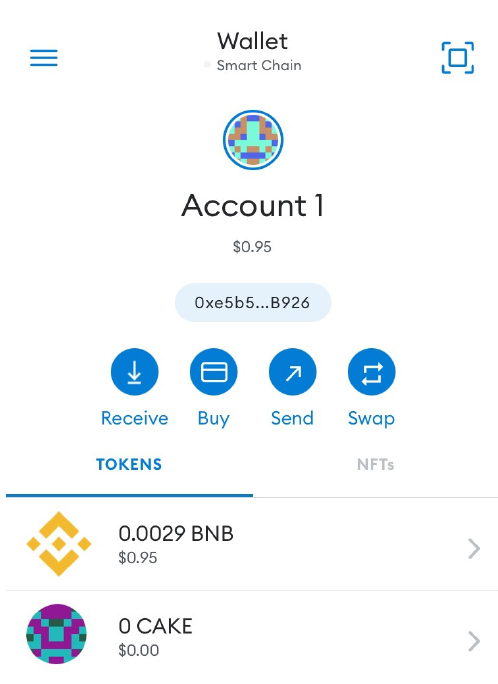
Figure 7. Screenshot snip-it that was taken by the